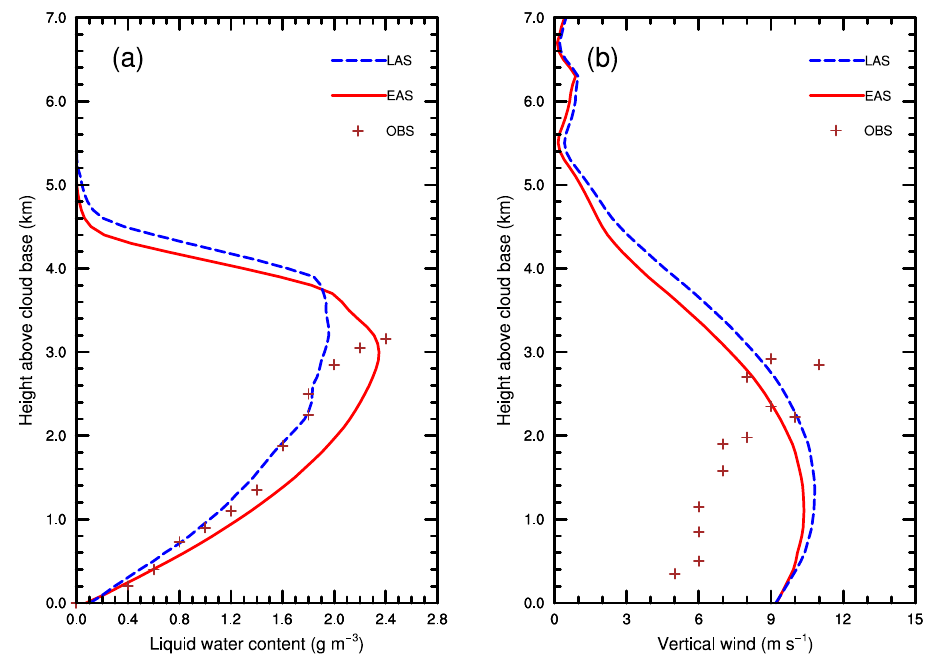
Figure 7. Comparisons between model results at 52.5 min with LAS, EAS, and OBS. ( a ) Liquid water content. ( b ) Vertical